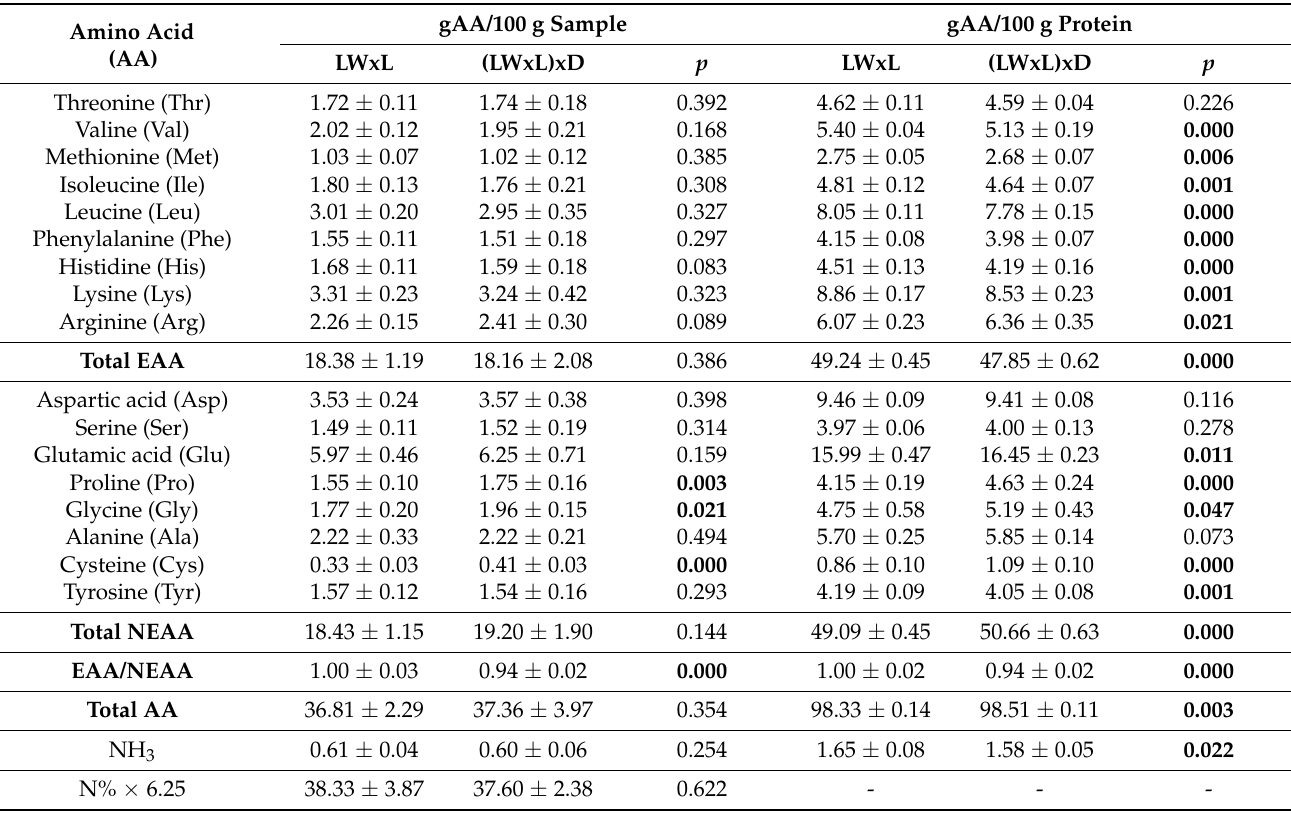
Table 3. Differences between pig genotypes in the AA composition (means ± standard error) of matured Istarski pršut